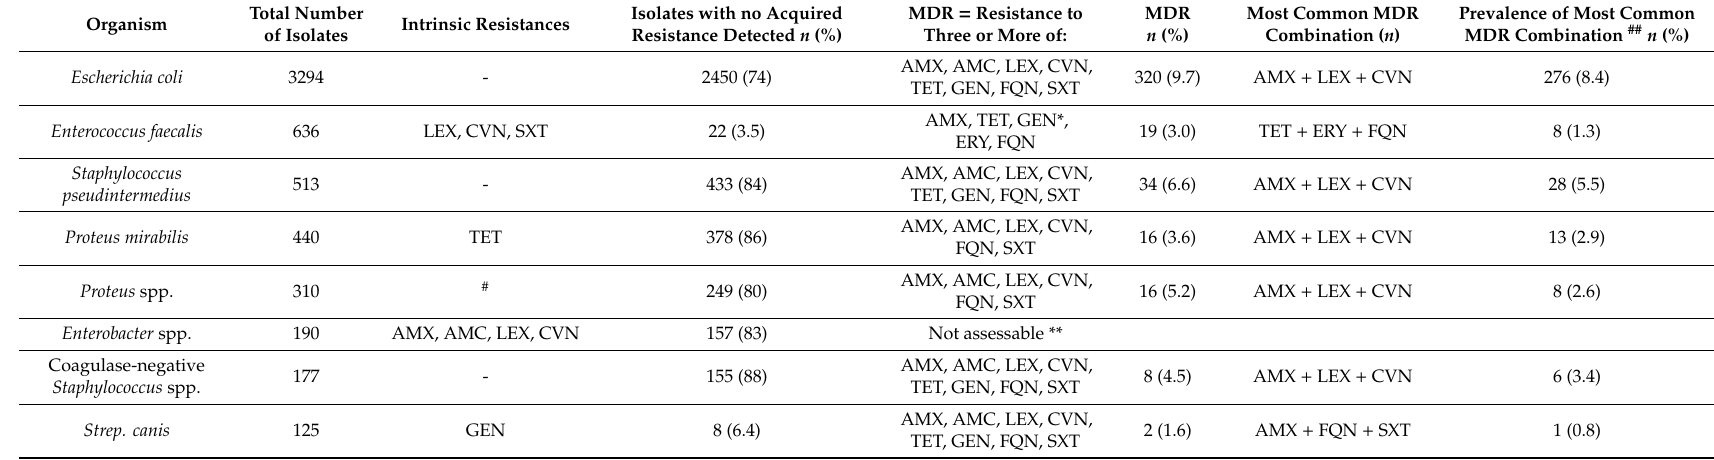
Table 4. Summary of antimicrobial resistance detected in the most prevalent bacterial species / genera isolated from dog and cat urine. MDR: multi-drug resistance.